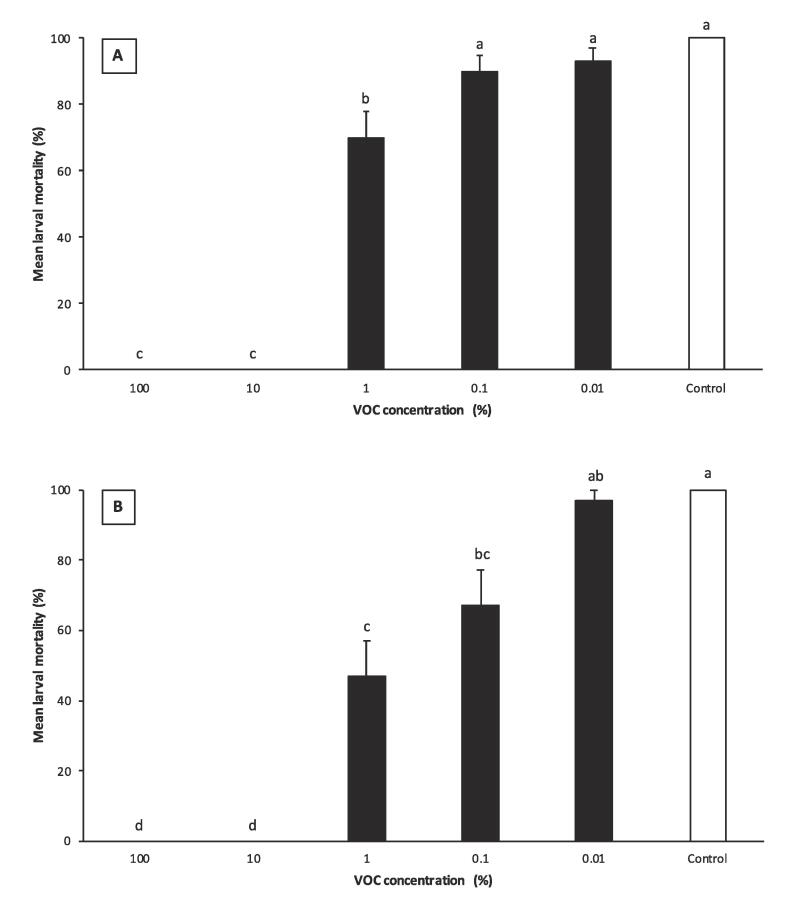
Corrected percentage mortality of Galleria mellonella larvae caused by nematodes exposed to 3-octanone (A) or 1-octen-3-ol (B). Data are expressed as mean ± SEM. The same lower case letter above the error bars indicates no significant difference (P < 0.05; Tukey’s test).